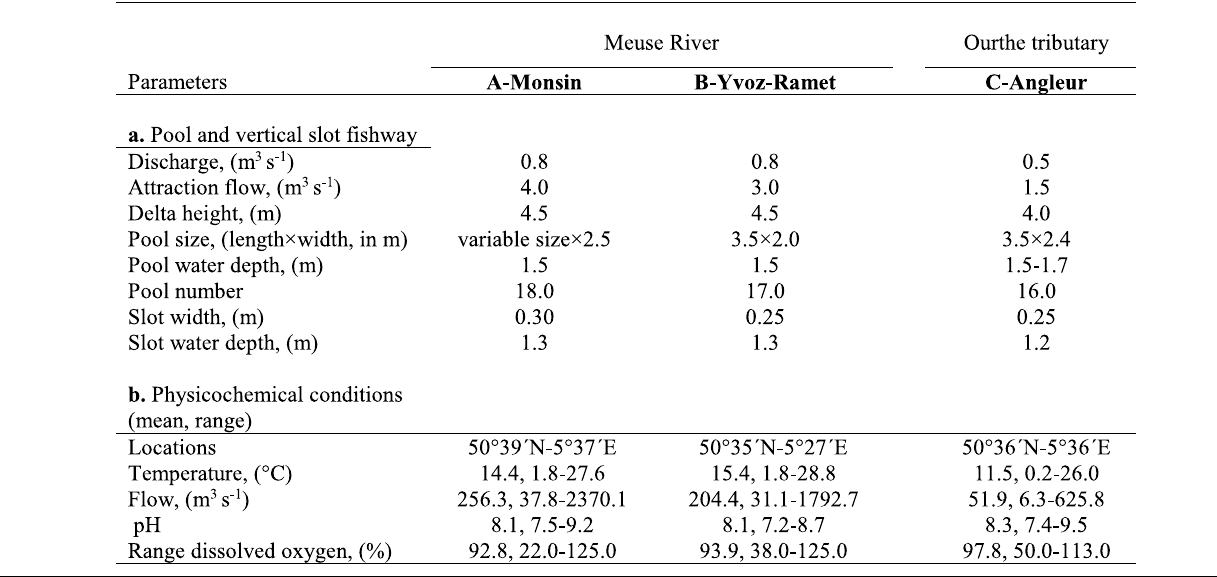
Table 1. Fishways and daily water physicochemical characteristics at the detection stations from 2010 to 2015.